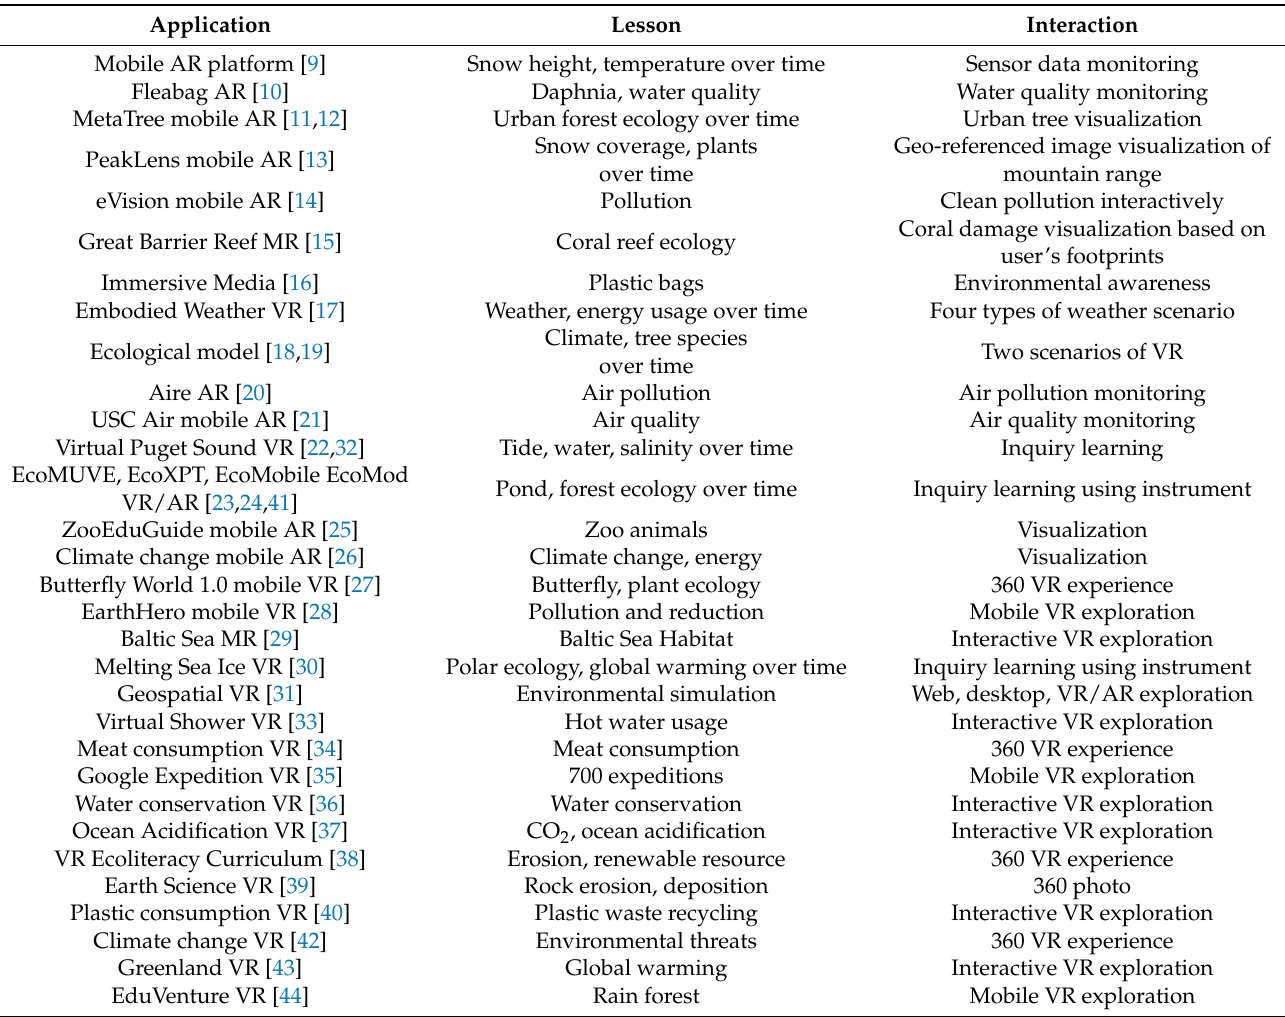
Table 1. Key features of virtual reality or augmented reality application for environmental